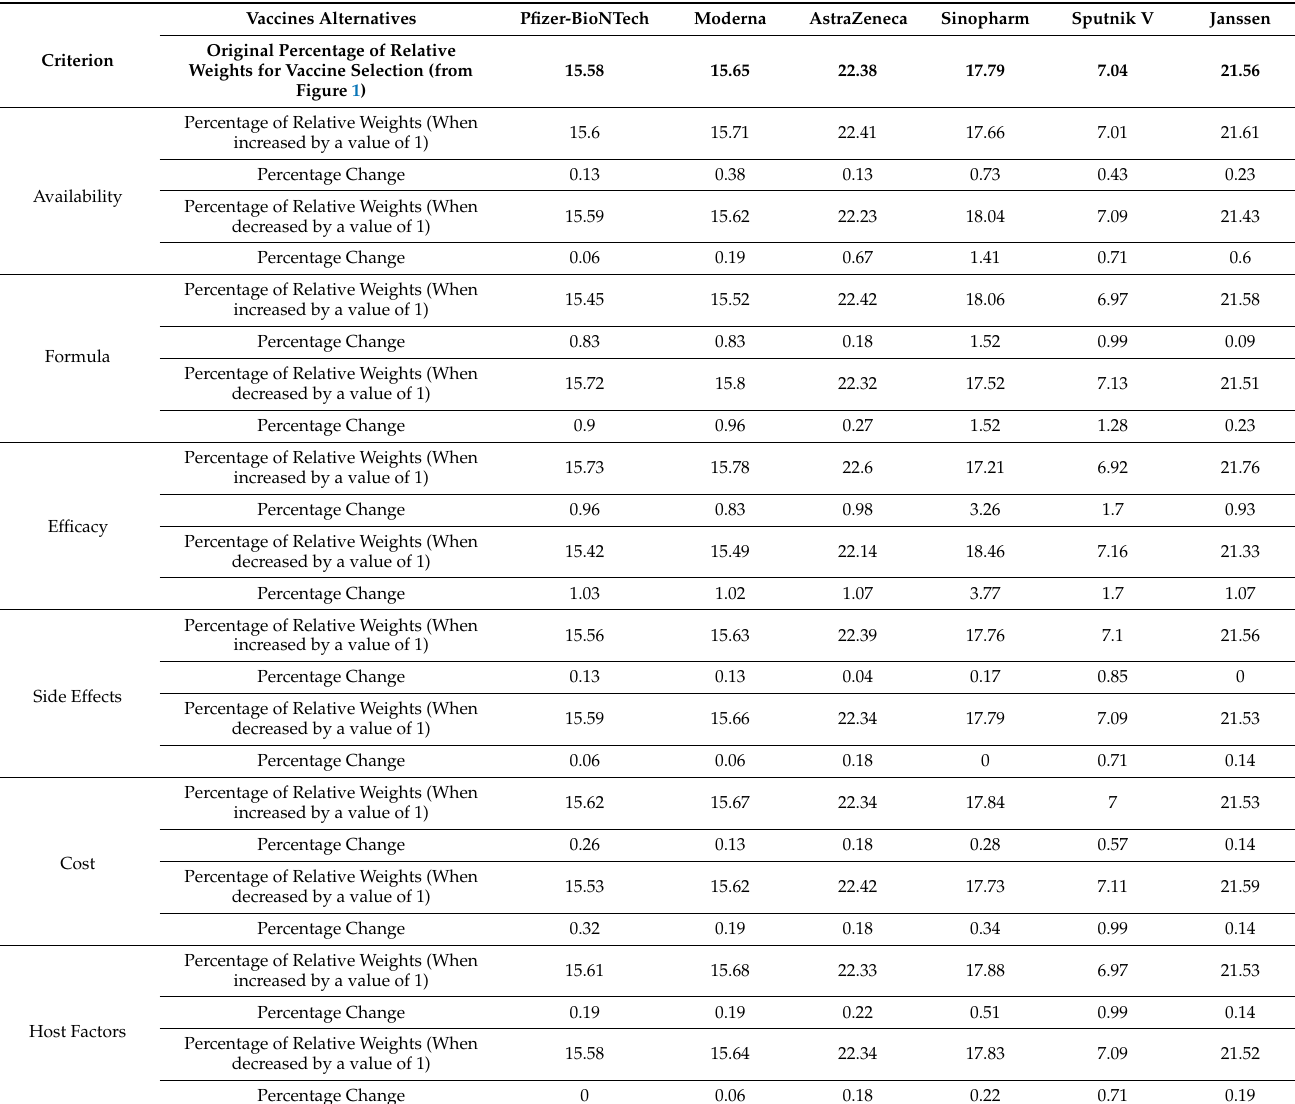
Table 5. Sensitivity analysis for data from respondent